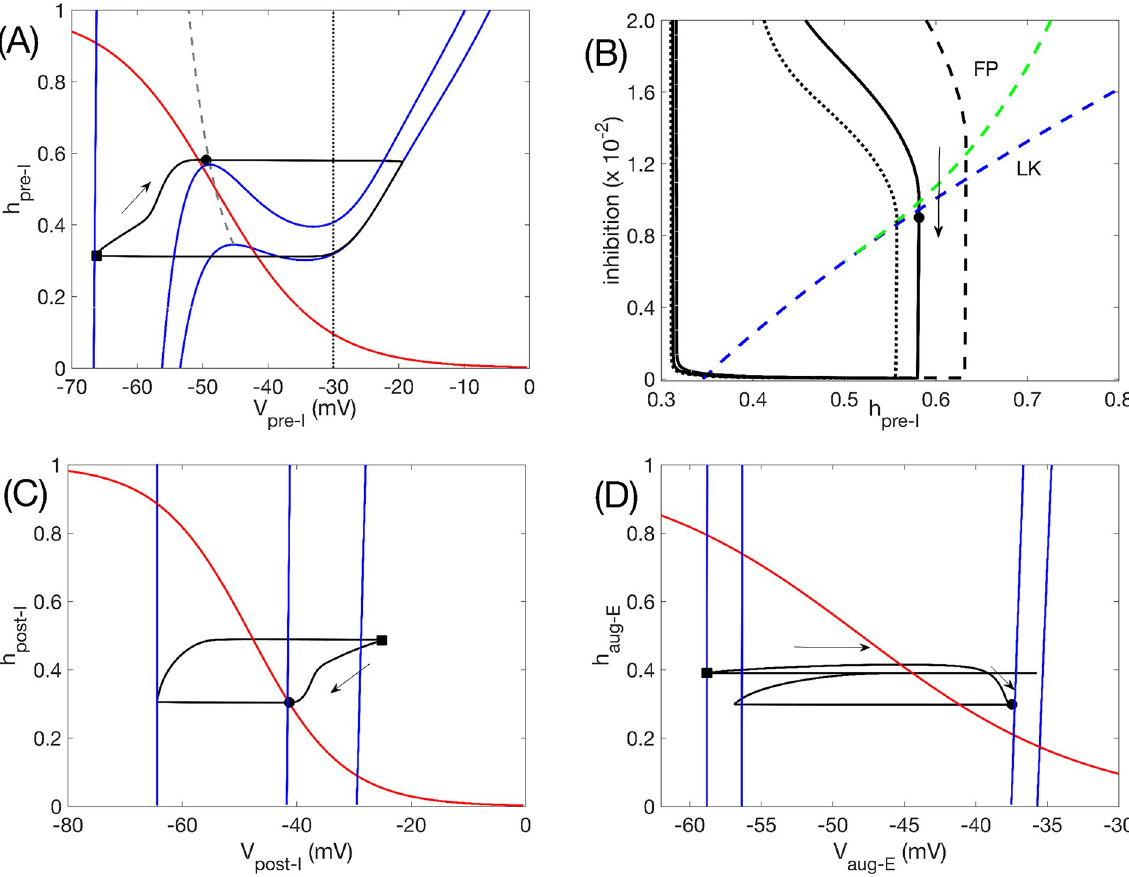
Fig 6. Network oscillation mechanisms when pre-I is intrinsically oscillatory, with c 11 = − 0.03. (A) Phase plane ( h versus V ) for the pre − I pre − I pre-I unit. Black curve is the model output projected to this plane. Solid blue curves are V pre − I -nullclines. The lower right nullcline corresponds to 0 inhibition to pre-I, the upper left nullcline (which continues out of the image) to the maximal inhibition received by pre-I (0.0965), and the middle nullcline to the inhibition level received by pre-I (0.09) when it begins its escape to the active phase by hitting the curve of knees (LK, grey dashed). The red curve is the h -nullcline, which is independent of inhibition level. The vertical black curve denotes the V value at which pre − I pre − I the output of pre-I is half of its maximum value. Solid black circles and squares correspond to time points when inhibition to the pre-I unit is 0.09 and 0.0965, respectively. (B) Same solution projected to the plane in which the inhibition to pre-I is plotted versus h (black solid). As pre − I inhibition wears off, the trajectory first crosses the curve of pre-I fixed points (FP, green dashed) and then crosses the curve of V -nullcline left pre − I knees (LK, blue dashed), allowing escape (black circle) and initiation of inspiration. Trajectories for reduced/increased inhibition from post-I to pre-I ( b 31 = 0.105/0.175) are also shown (dotted/dashed black). (C) Phase plane ( h versus V ) for the post-I unit. Curves are analogous to post − I post − I those in (A). The V post − I -nullclines shown correspond to minimal inhibition to post-I (far right, inhibition is 0), occurring when the maximal value of V is achieved along the trajectory (black square, same time point as in (A)); to maximal inhibition to post-I (far left, inhibition is post − I 0.54); and to the inhibition level when pre-I initiates its escape (middle, inhibition is 0.0525, also marked by solid black circle at same time point as in (A)). (D) Phase plane ( h versus V ) for the aug-E unit. Curves are analogous to those in (A). From right to left, the V -nullclines aug − E aug − E aug − E shown correspond to minimal inhibition to aug-E (inhibition is 0.05); to inhibition to aug-E at the moment when pre-I initiates its escape (inhibition is 0.0542, also marked by black circle at same time point as in other plots); to inhibition to aug-E when V pre − I is at its peak (0.283); and to inhibition to aug-E when V is at its peak (0.35, marked by black square at same time point as in other plots). post − I